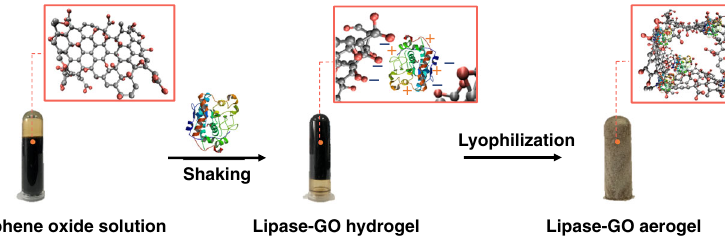
Fig. 1 Preparation procedures of LGA. LGA preparation by one-step co-gelation and lyophilization after mixing GO and CALB